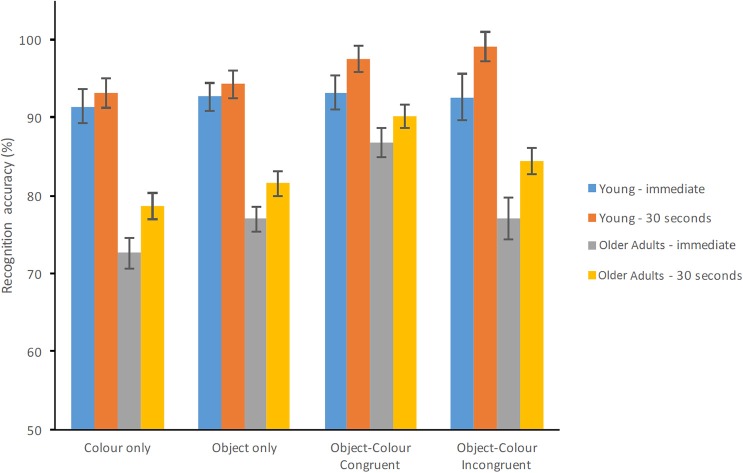
Percentage of correct recognition for healthy young and older adults for each test condition and test delay (Error bars represent the standard error of the mean).